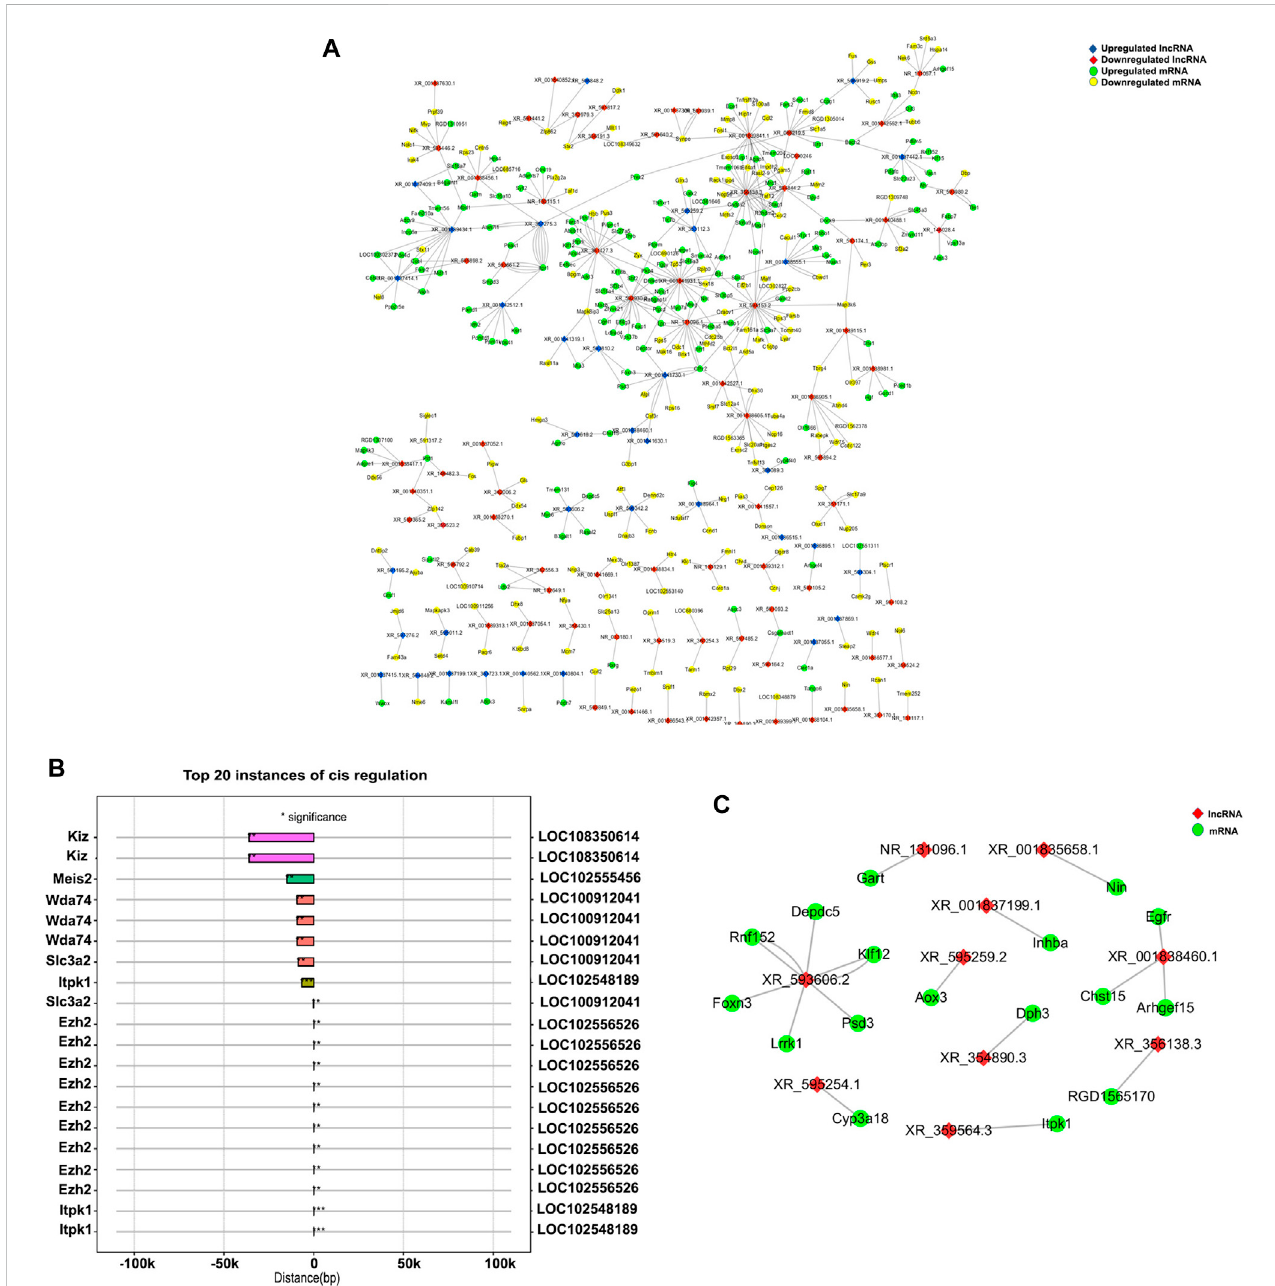
FIGURE 6 Visualization of mRNA – lncRNA co-expression network. (A) Network of mRNA – lncRNA co-expression drawn using Cytoscape 3.7.2. (B) Cis-regulated mRNA – lncRNA correlations. Number of asterisks indicates the level of signi fi cance: ***0 < p < 0.001; **0.001 < p < 0.01; *0.01 < p < 0.05. The left and right Y -axes represent mRNAs and lncRNAs, respectively; the X -axis represents the distance between the mRNA and lncRNA, with negative values indicating upstream distance and positive values downstream. Bars of the same color represent the same lncRNA. (C) Network diagram of mRNA – lncRNA trans target interaction, also drawn using Cytoscape 3.7.2. Red nodes represent lncRNAs; green nodes represent